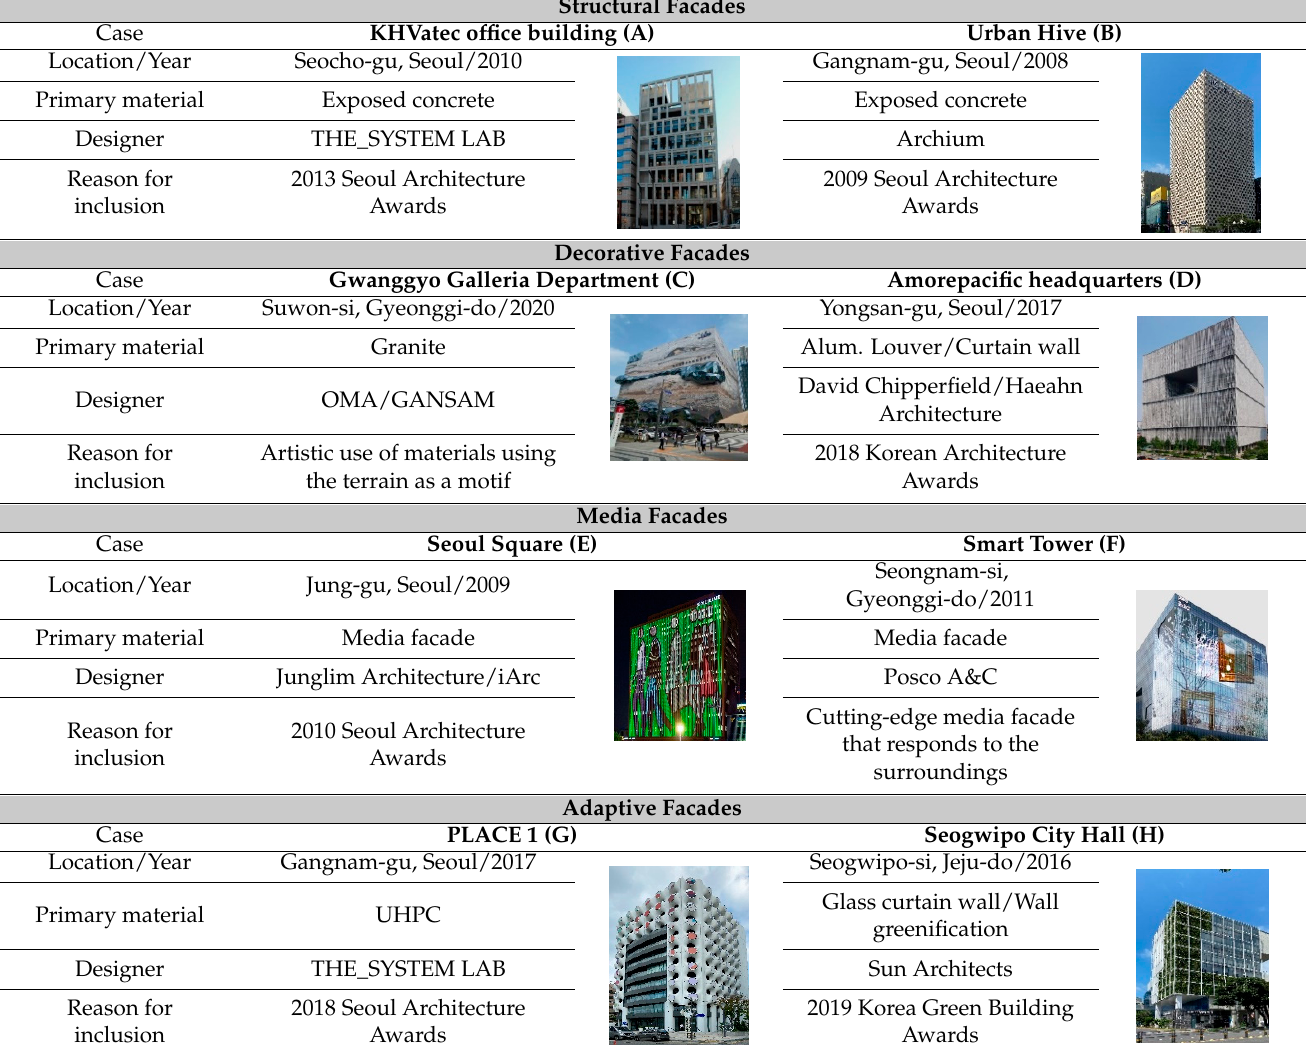
Primary material UHPC Designer Reason